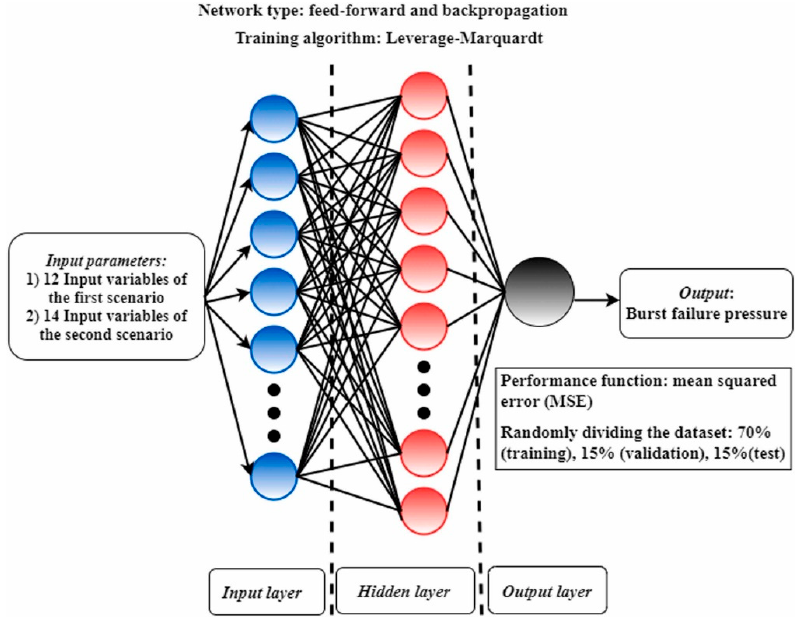
Figure 33. The architecture and details of the constructed ANN [128].